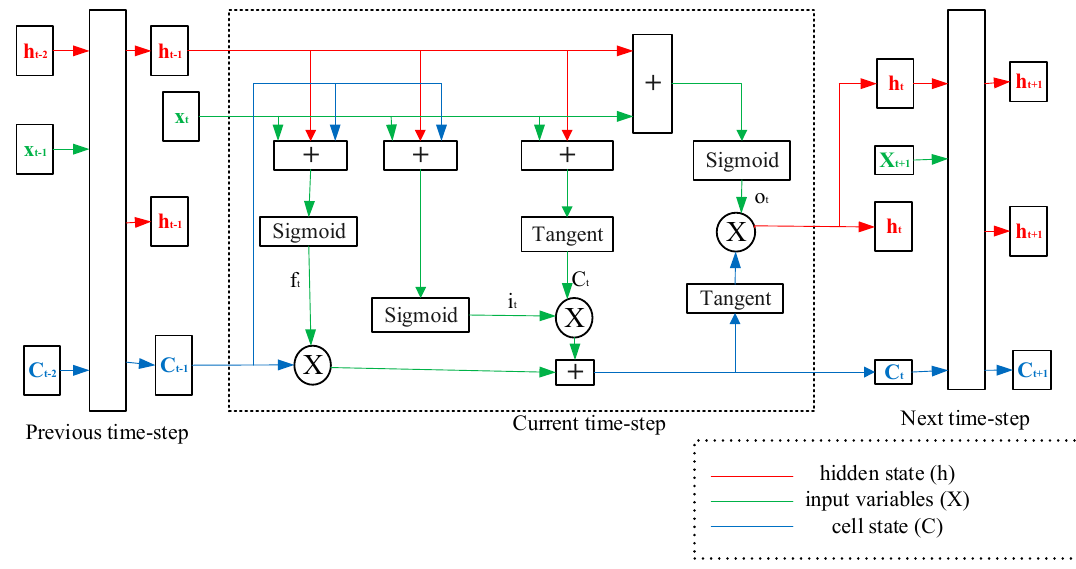
Figure 1. Long short-term memory (LSTM) memory cell architecture redrawn from [19,20].